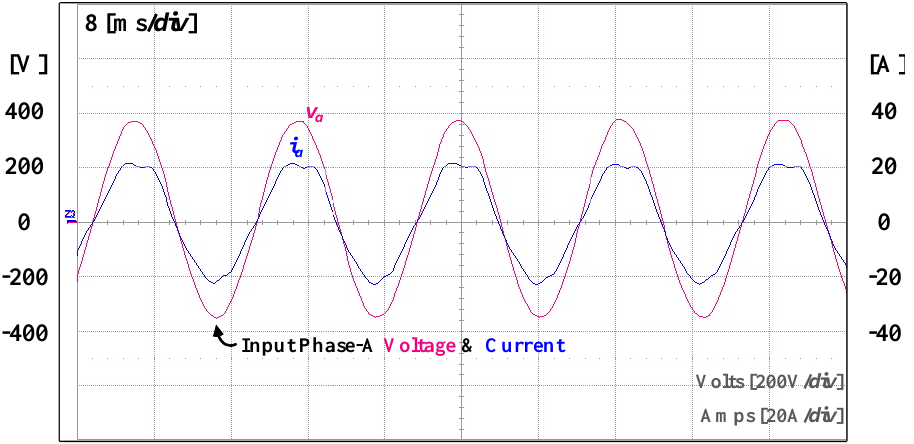
Figure 27. Waveform of input phase a voltage and current.